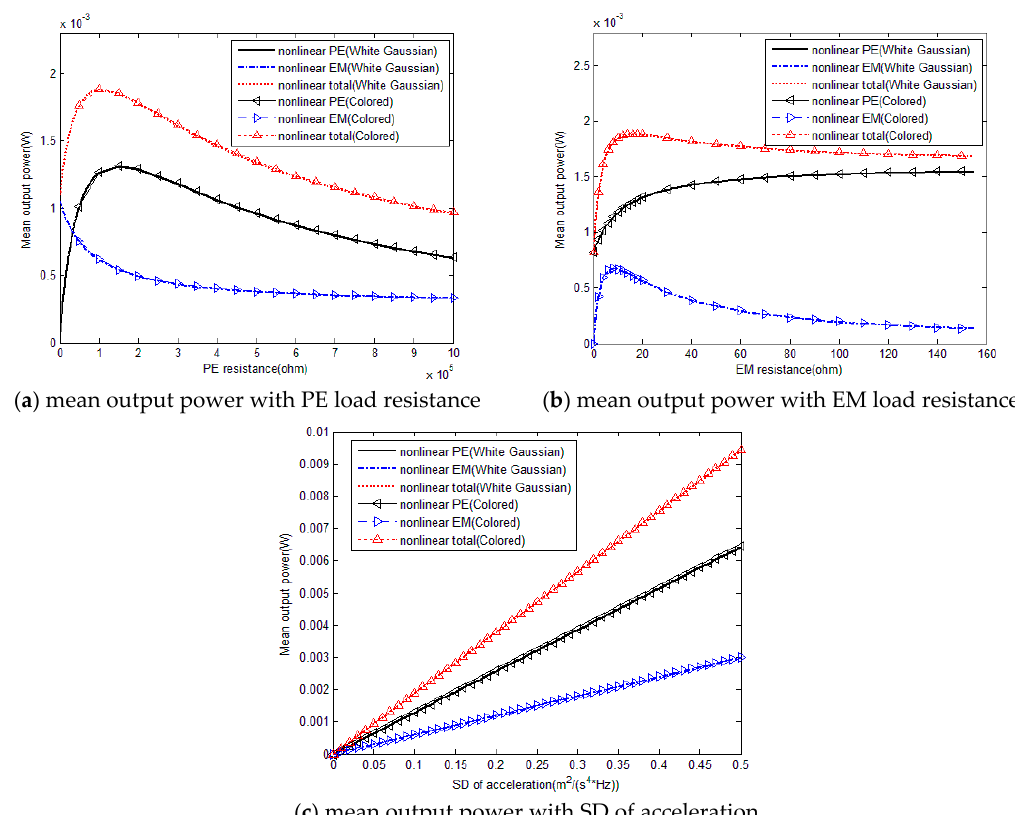
Figure 6. Mean output power of nonlinear hybrid energy harvester under White Gaussian and colored excitation.